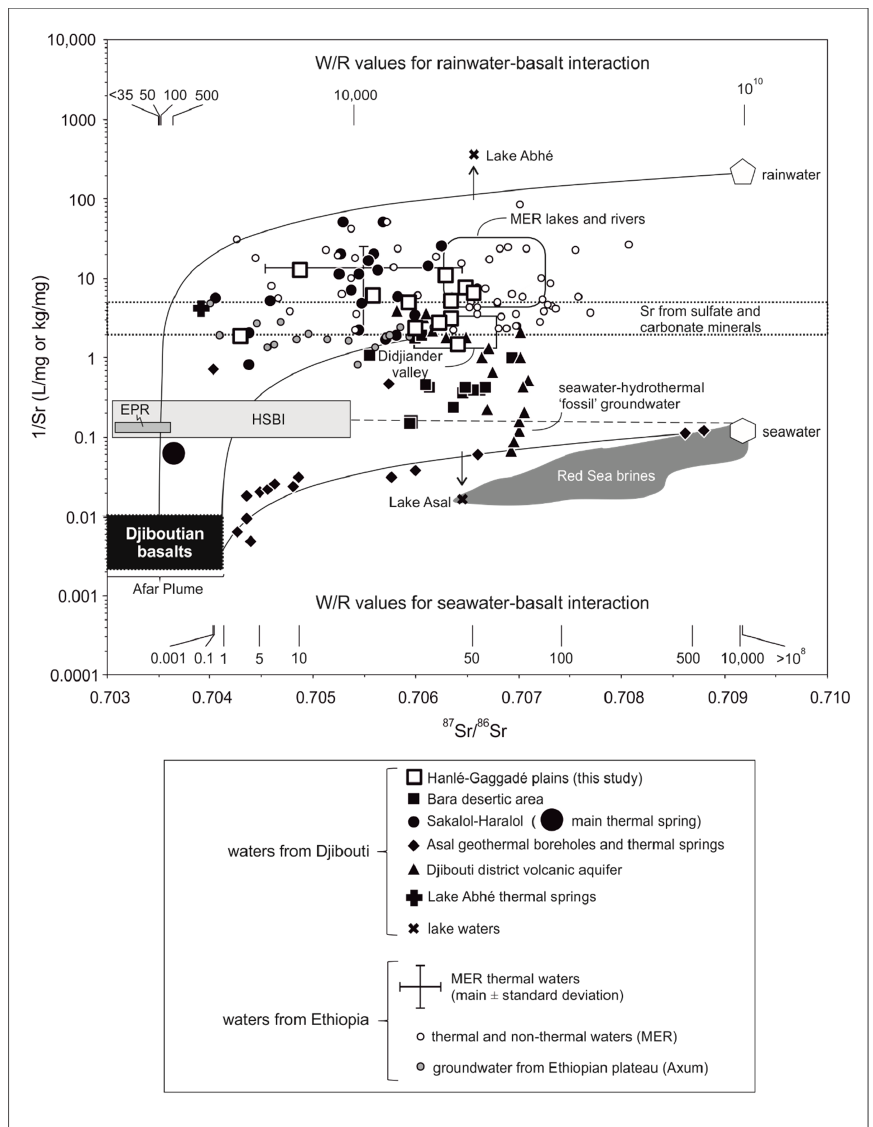
Figure 2. A 1/Sr versus 87 Sr/ 86 Sr diagram showing the comparison between the waters from Djiboutian Afar [20,26–29], the Ethiopian MER [39,40], and the Ethiopian Northern plateau [41]. Solid curves depict both mixing lines between the two endmembers located at the start and the end of each curve [47] and the water–basalt interaction modelling according to Equation (3) [16,52,53]. In this latter case, the obtained W / R ratios ( N in Equation (3)) considering rainwater or seawater as the initial fluid (that is, the uppermost and the lowermost curve, respectively) are also shown. The compositional range of the most recent Djiboutian basalts of the Dahla, Stratoid, and Asal Series (i.e., from 9 Ma to date [30]) and Afar plume represent the main solid endmember or interactant (see the text for details and for the specific compositional range). The hydrothermal waters sampled at the bottom of the Red Sea (the ‘Red Sea brines’ grey field, [54–58]), those issuing from the 21 ◦ N East Pacific Rise (EPR, dark grey field, [59–61]), and those obtained from the Hydrothermal Seawater Basalt Interaction (HSBI, light grey field, [62,63]) are also shown for comparison. The horizontal dashed line depicts the binary mixing between seawater and the HSBI